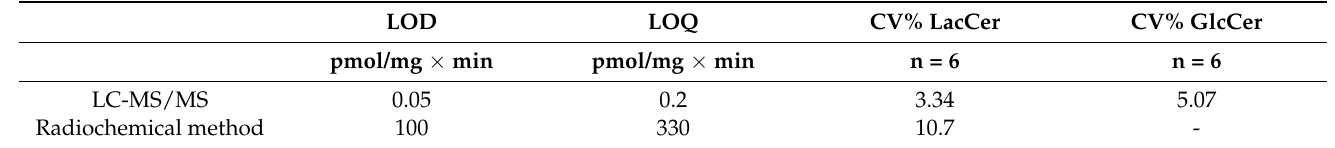
Figure 8. Detection of LacCer synthase by the novel method in cells expressing low levels of activity. Comparison of GlcCerd7 ( A ) and LacCerd7 ( B ) profile in HEK-293T and fibroblasts. To obtain these chromatograms, 40 µ M of GlcCerd7 with 1 mg/mL of homogenate protein was incubated for 60 min. Table 2. Comparison between method performances: liquid chromatography coupled to mass spectrometry (LC-MS/MS) vs. radiochemical method. The comparison was based on analytical pa- rameters such as the limit of detection (LOD), limit of quantification (LOQ), and precision (calculated as coefficient of variation